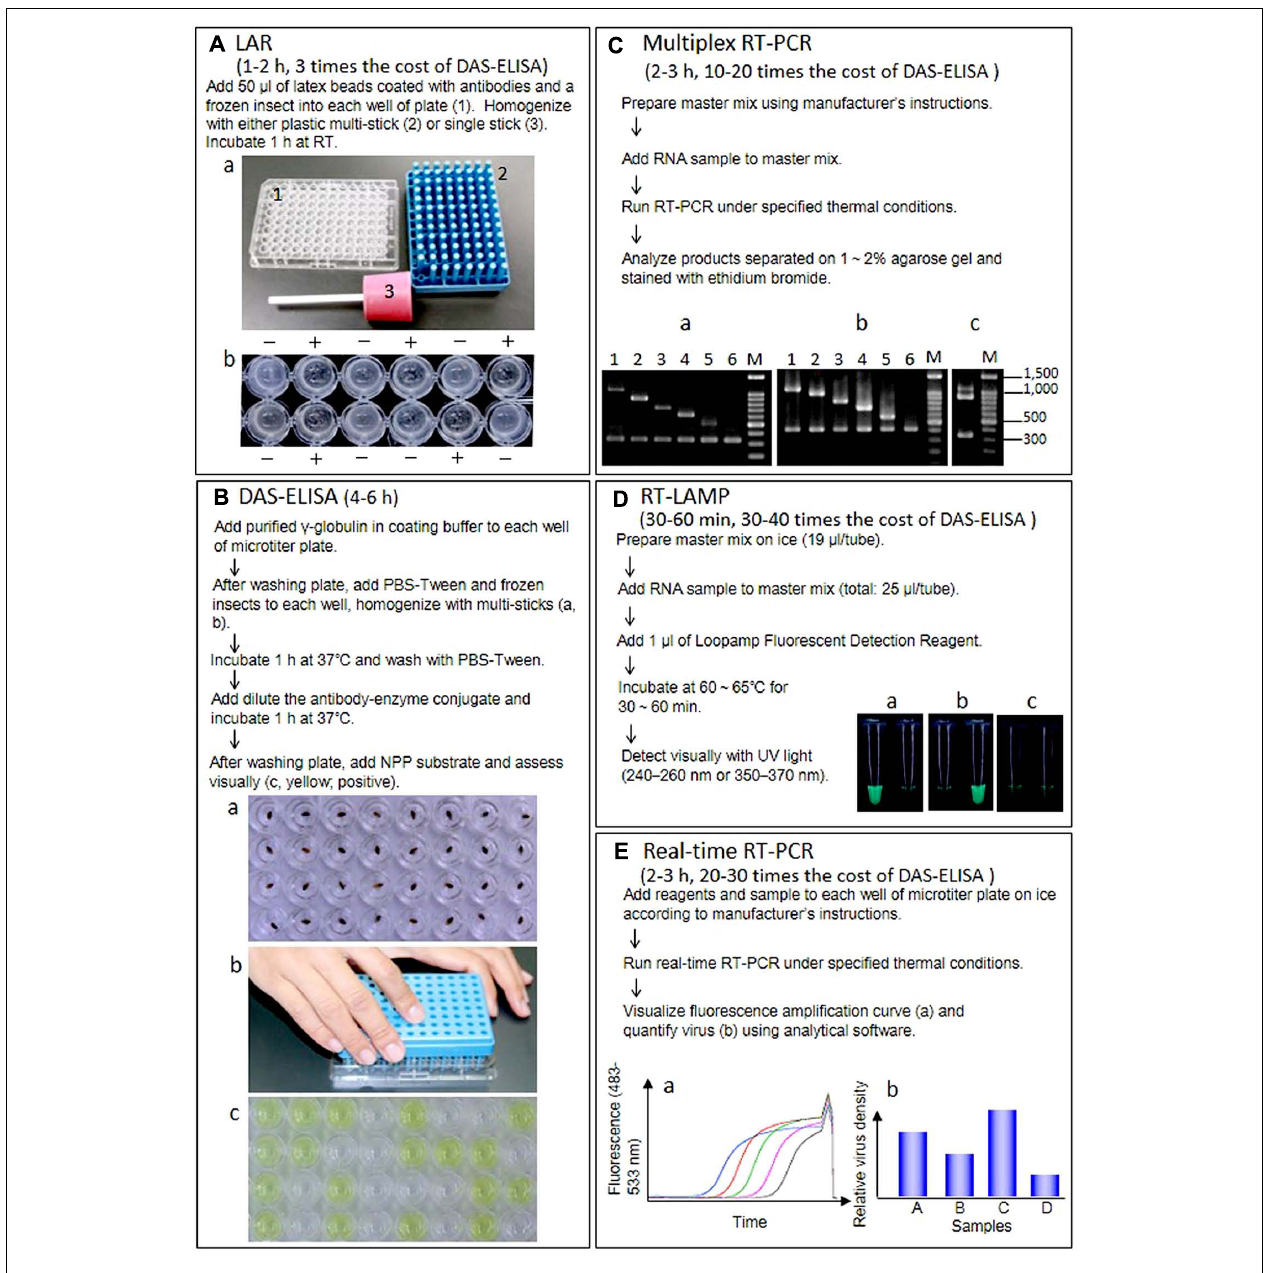
FIGURE 1 | Outline of procedure, required time, cost comparison of reagent kits per diagnosis, and results of five techniques . (A) Latex agglutination reaction (LAR) to detect RSV in insect vectors. RT, room temperature. (a) Materials for LAR and DAS-ELISA. (1) Microtiter plate, (2) multi-sticks, (3) single stick. (b) Results of LAR. + , positive, − , negative. (B) DAS-ELISA to detect RSV in insect vectors. (a) The frozen insects in each well. (b) Homogenization of insects with multi-sticks. (c) Visual assessment. (Yellow; positive). (C) Multiplex RT-PCR to detect and distinguish 10 rice viruses. (a) Agarose gel electrophoresis of RT-PCR products from healthy or infected rice plants using primer set I. Lane 1, infected with RDV (1106 bp); lane 2, infected with RSV (917 bp); lane 3, infected with RBSDV(734 bp); lane 4, infected with RTYV (631 bp); lane 5, infected with RTSV (504 bp); lane 6, healthy plant (339 bp). (b) Agarose gel electrophoresis of RT-PCR products from healthy or infected rice plants using primer seII. Lane 1, infected with SRBSDV